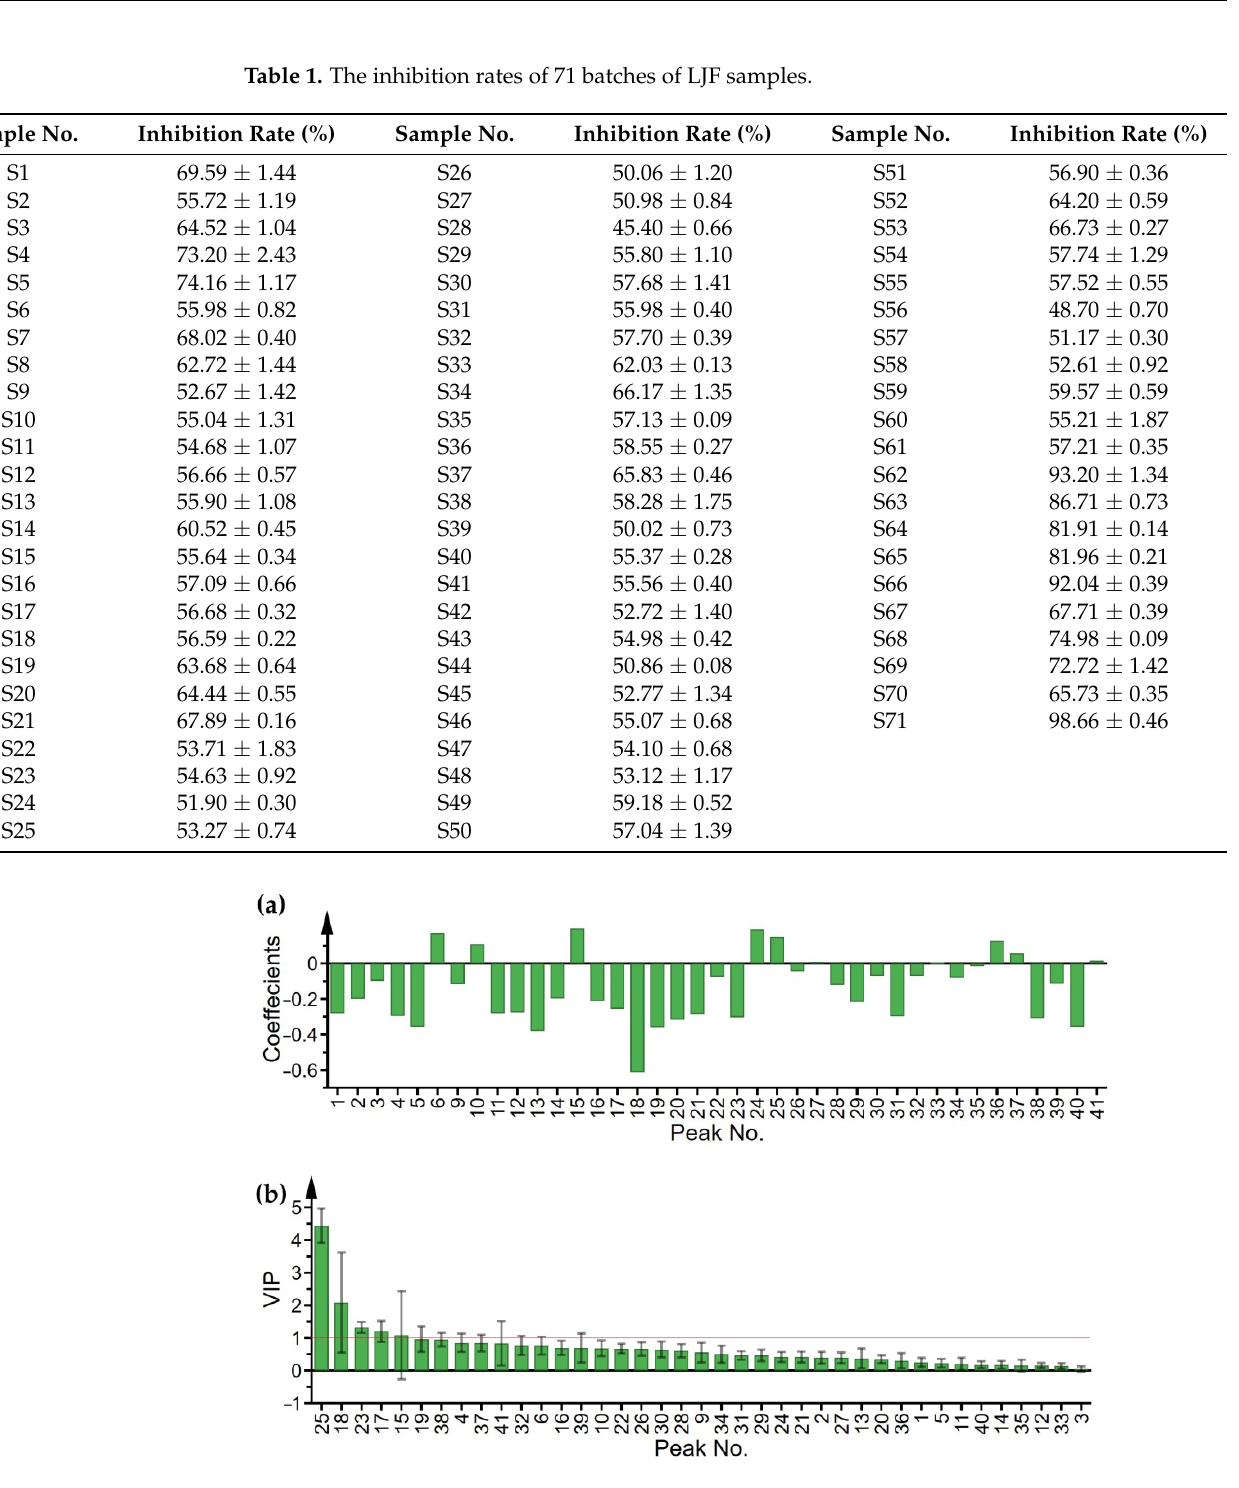
Figure 2. ( a ) Coefficients plot from OPLS, ( b ) VIP plot from OPLS.